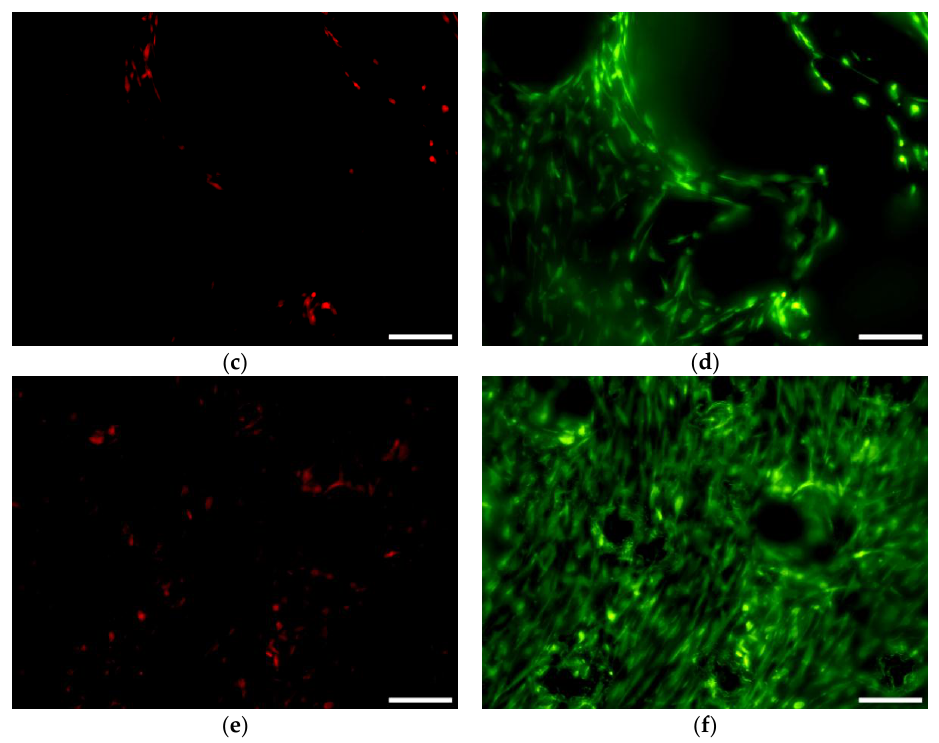
Figure 18. Live-dead staining of hMSC cultured for 7 days in expansion medium within ( a , b ) 500 µm pore scaffolds; ( c , d ) bimodal 500 µm and 200 µm pore scaffolds; and ( e , f ) 200 µm pore scaffolds. Red—dead; Green—live. b , d and f —merged images of dead and live cells. Scale bar 200 µm.